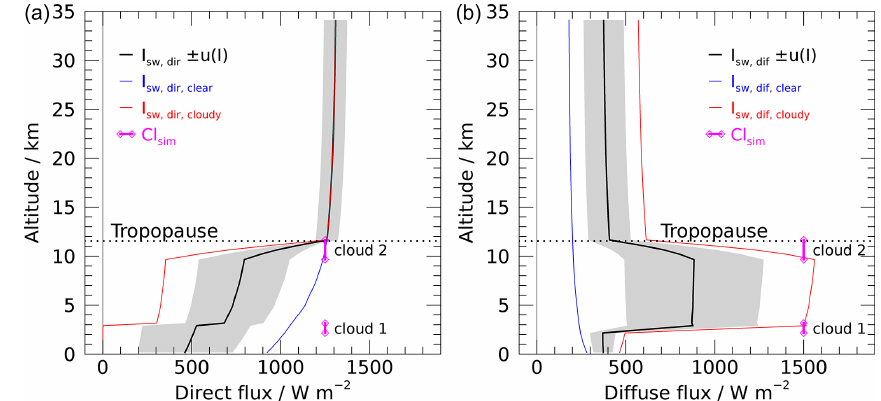
Figure 17. Example of simulated solar radiation fluxes including uncertainty estimates (Lindenberg, 11 June 2020, 12:00UTC, solar- elevation angle ∼ 59 ◦ ). (a) Direct solar radiation. (b) Diffuse radiance from surface albedo, and cloud reflection and